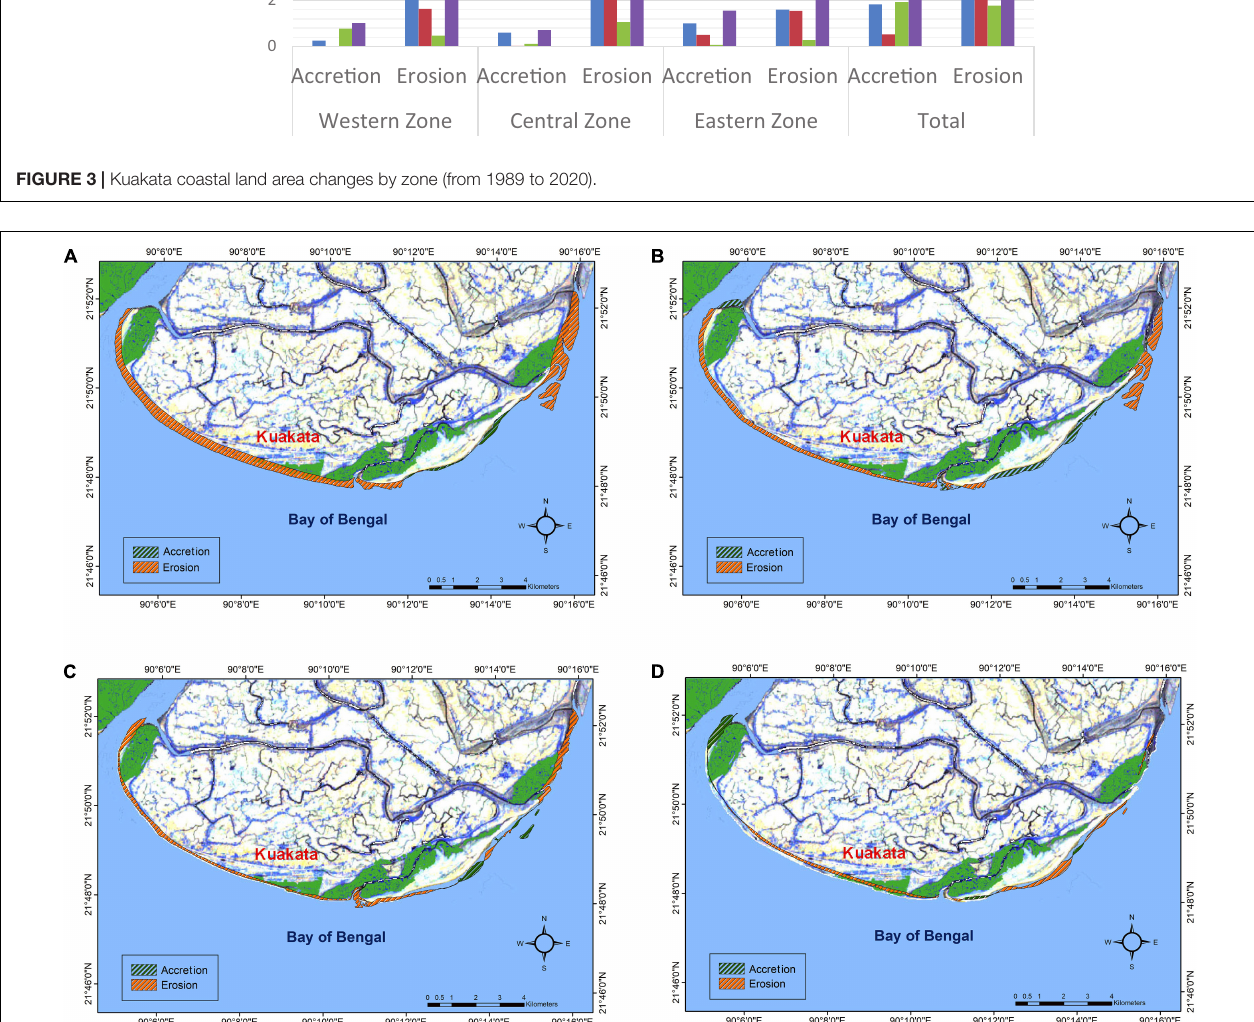
FIGURE 4 | Erosion and accretion at Kuakata coast from (A) 1989 to 2020, (B) 1989 to 2003, (C) 2003 to 2010, and (D) 2010 to 2020. Notice the very small coastal areas, mostly in the west, of net accretion, and net erosion